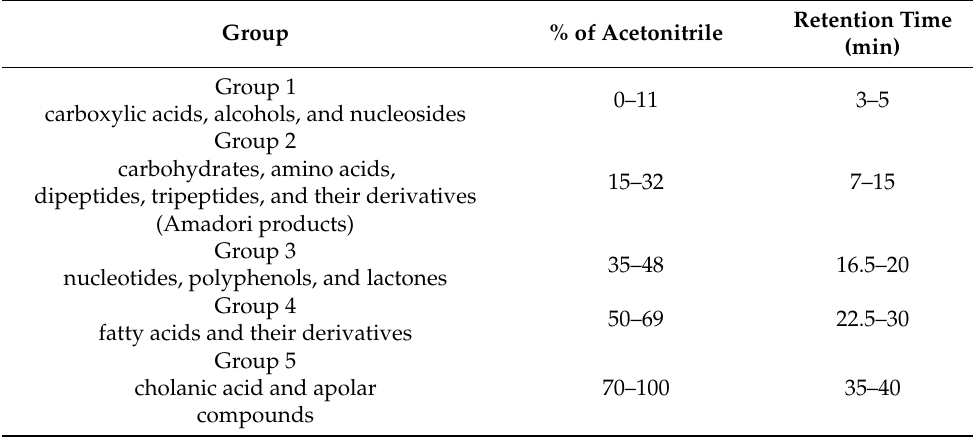
Retention Time (min)